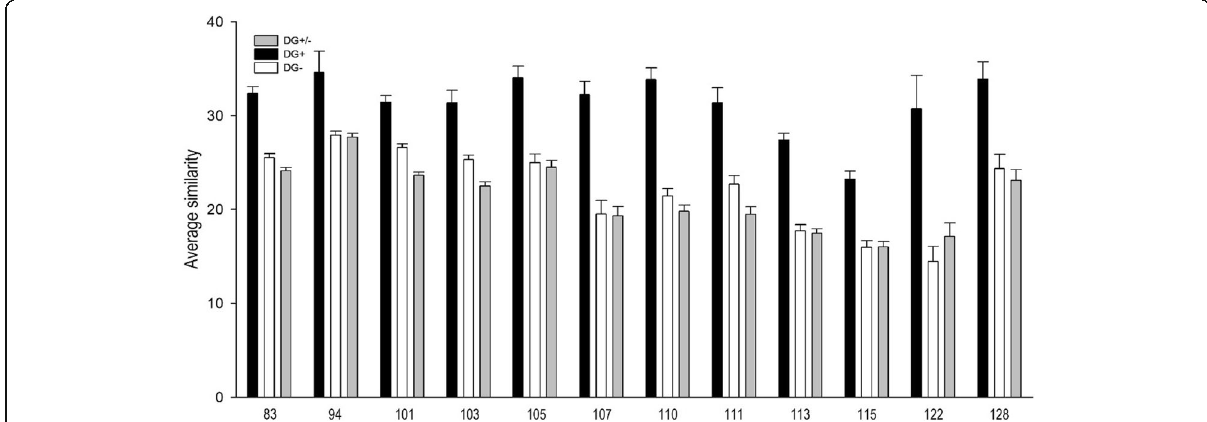
Fig. 4 Similarity values calculated for the groups of invaded sites (Dg+, black bars), non-invaded sites (Dg-, white bars) and the comparison between them (Dg+/Dg-, grey bars) in the basins (numbers). Note that the invaded basins have greater similarities than the non-invaded basins. Biobio River Basin (83), Tolten River Basin (94), Valdivia River Basin (101), Bueno River Basin (103), Puelo River Basin (105), Yelcho River Basin (107), Palena and coastal Rivers in the Southern Limit of the Tenth Region River Basin (110), Coastal and Island Rivers Between Palena River and Aysen River Basins (111), Aysen River Basin (113), Baker River Basin (115), Coastal Rivers Between Seno Andrew and Hollemberg River and Rivers to the East River Basins (122), and Tierra del Fuego